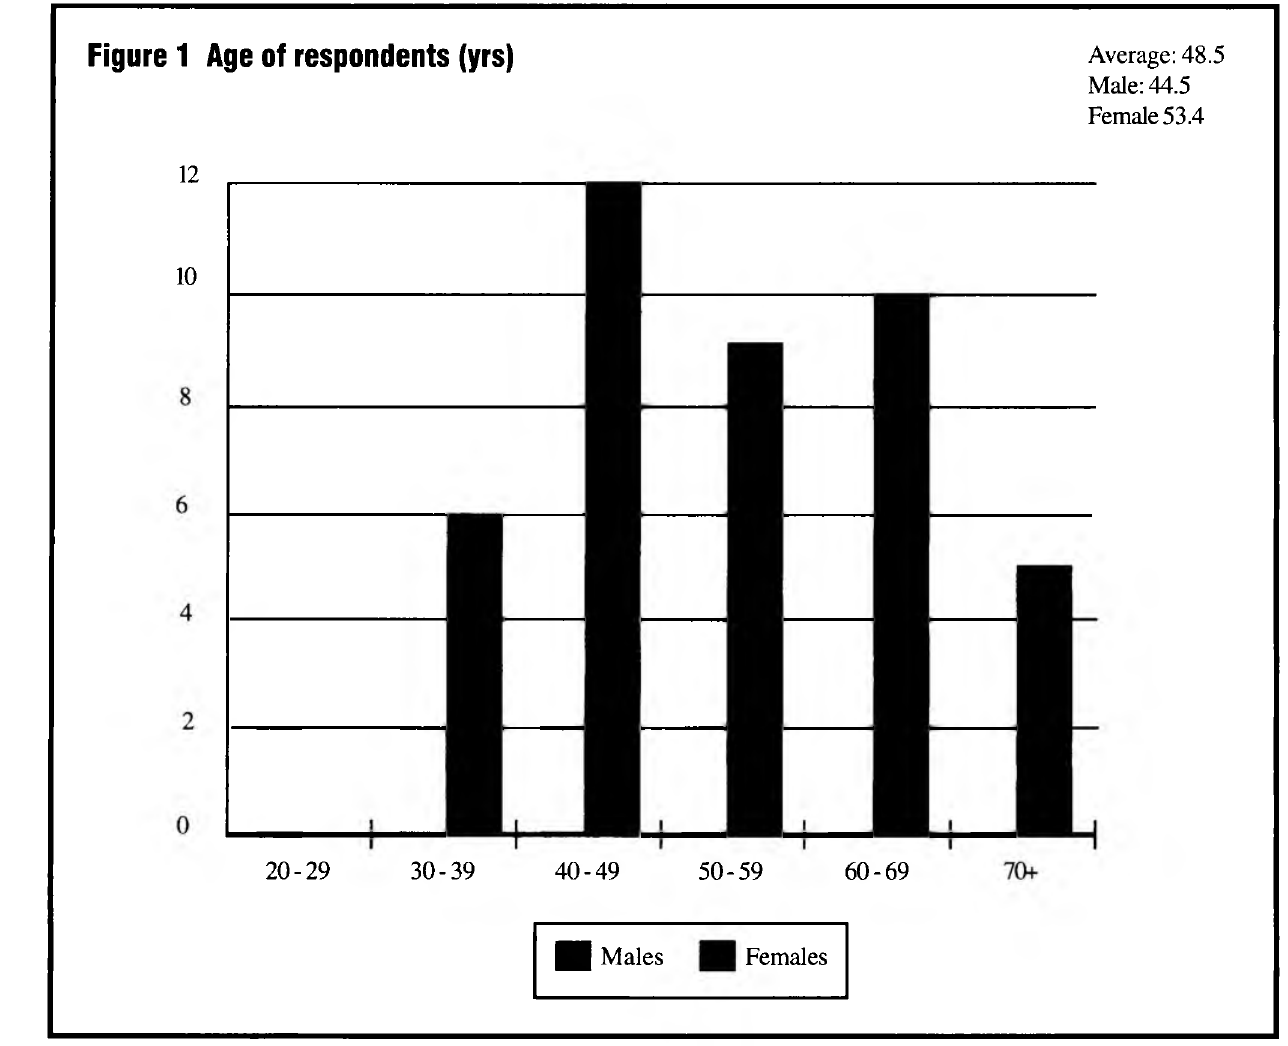
Figure 1 Age of respondents